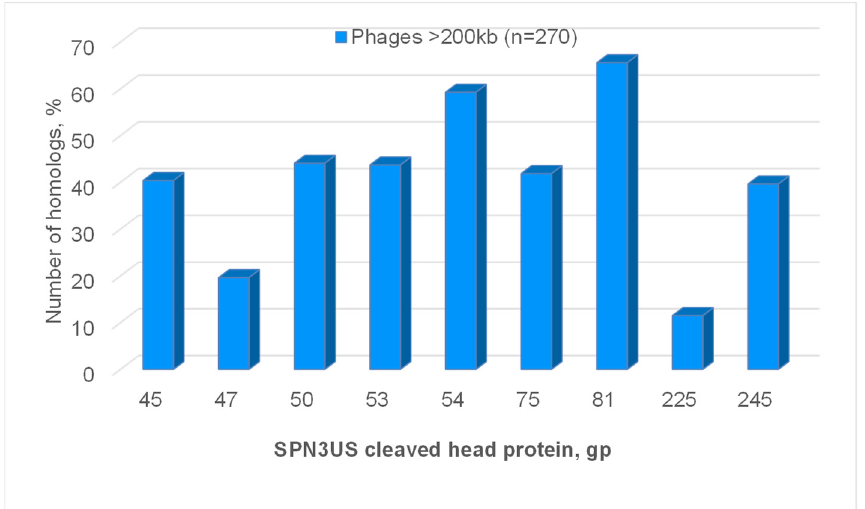
Figure 6. Numbers of homologs to cleaved SPN3US head proteins in long >200 kb genome phages identified by BlastP.